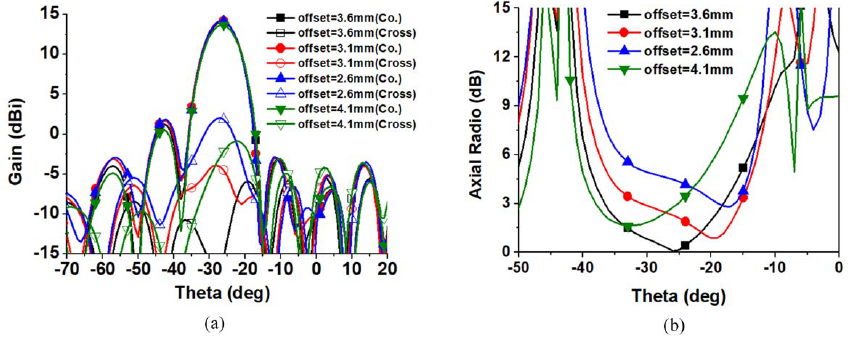
Figure 11. Simulated ( a ) gain and ( b ) axial ratio for the two antennas with different offsets at 17.3 GHz in the x–z